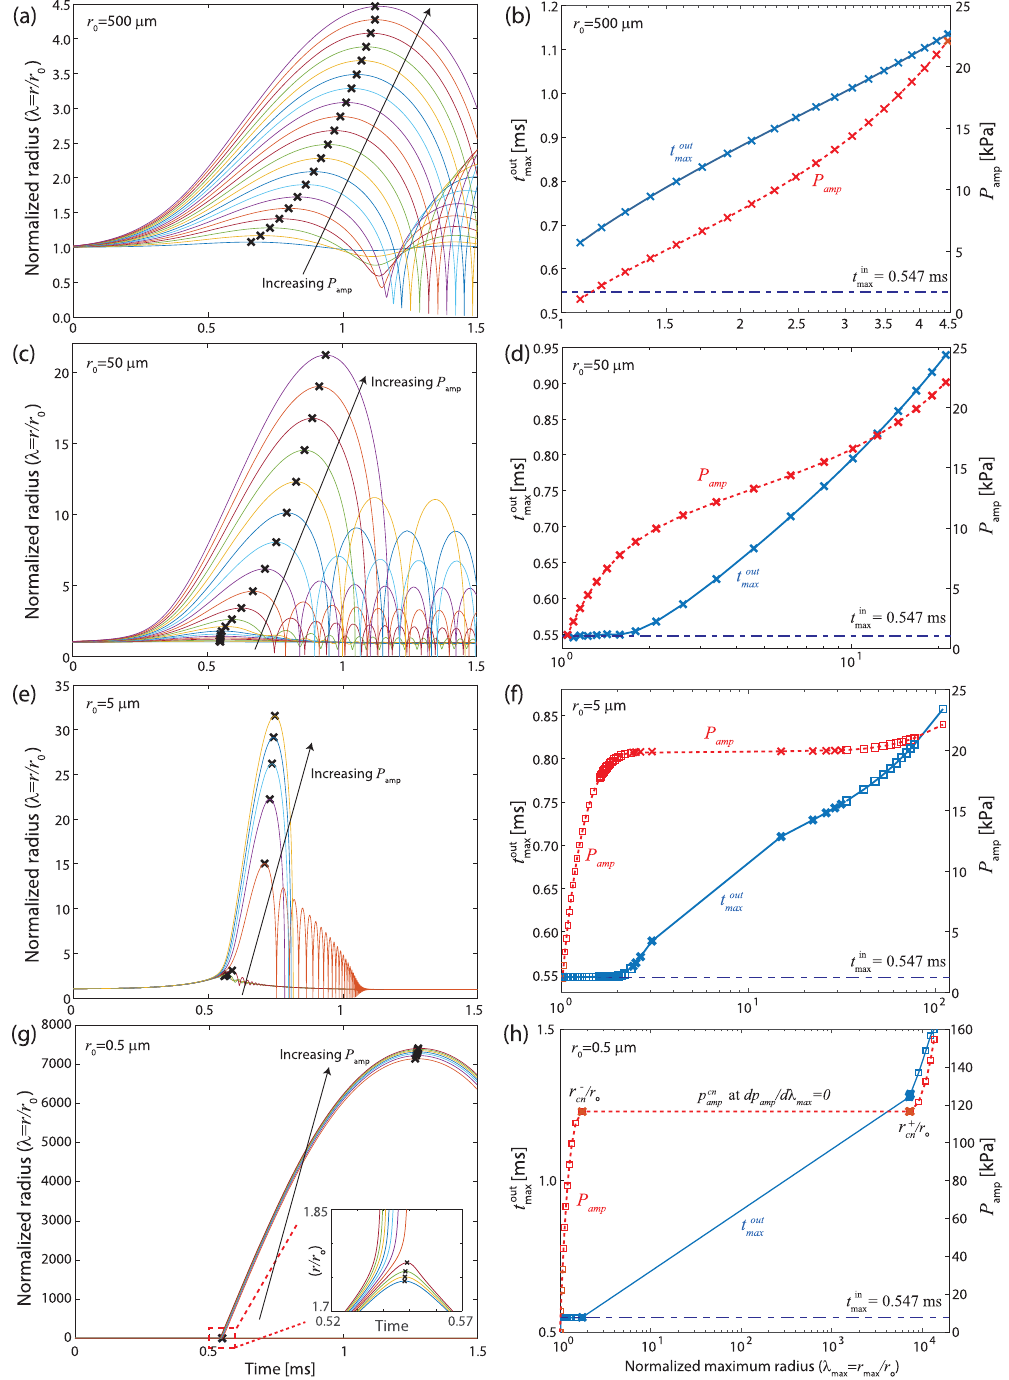
Figure 5. Numerical simulation to predict transient, dynamic response of an air bubble to impact. ( a , c , e and g ) The normalized bubble radius ( λ ( t ) = r ( t )/ r 0 ) for a different initial bubble radius, i.e., r 0 = 500, 50, 5, and 0.5 μ m, respectively, with linearly increasing amplitude of input pressure ( p amp ). “x” markers indicate the normalized maximum radius ( λ max = r max / r 0 ) at = t t out for a given p amp . ( b , d , f , and h ) summarize how t out and r max max max (vertical axis on the left) as well as p amp and r max (vertical axis on the right) are correlated based on the results from a, c, e, and g,